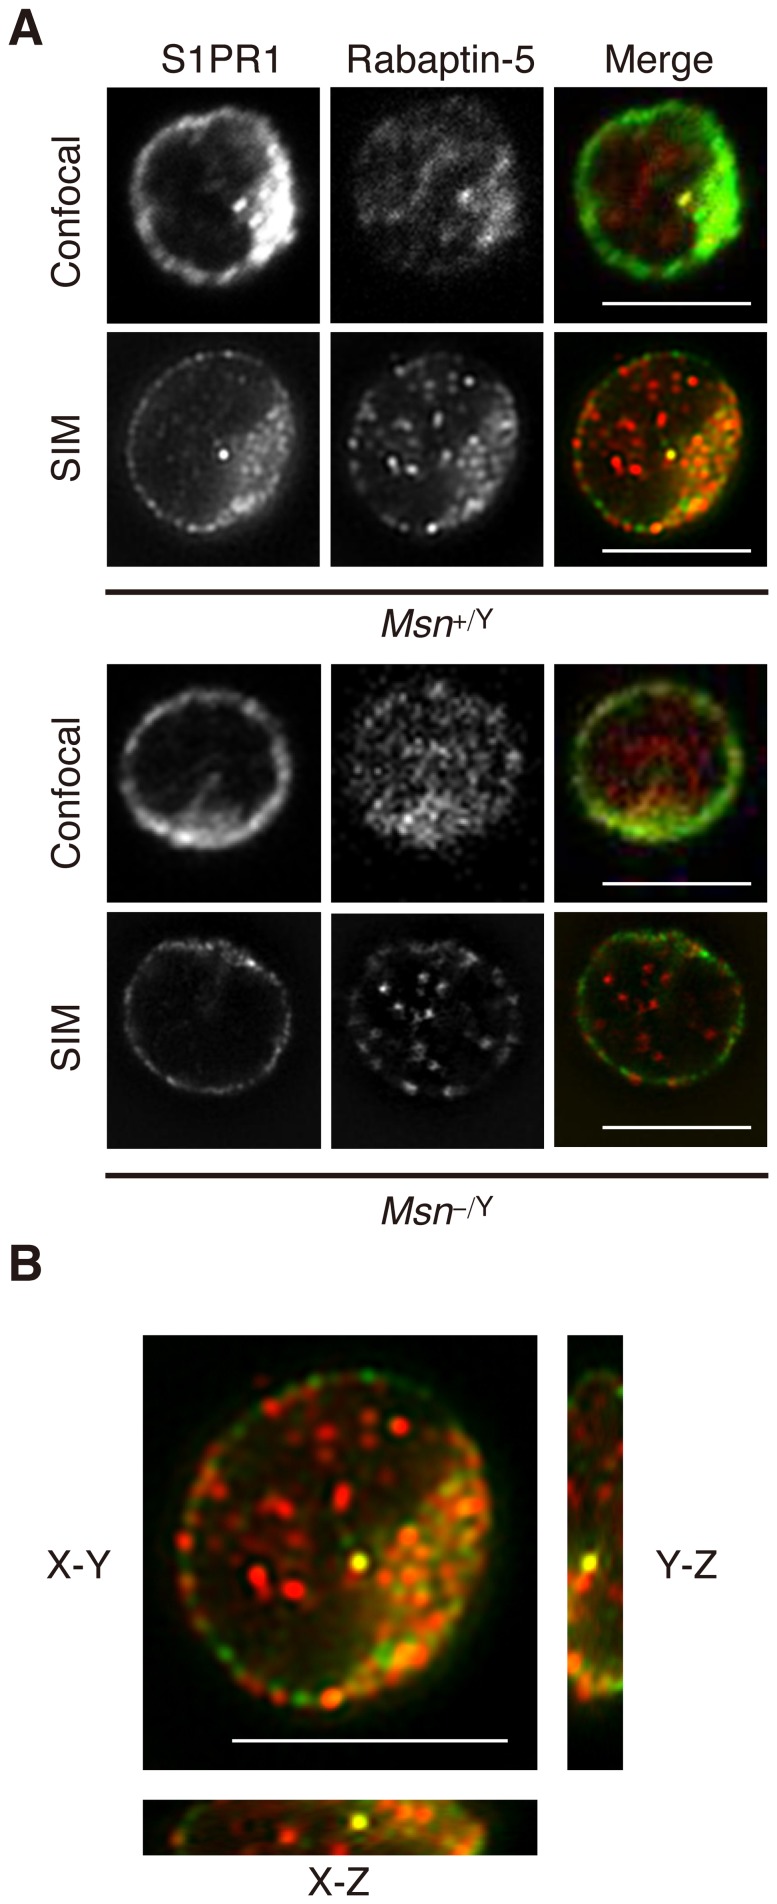
Super-resolution SIM images of S1PR1 and Rabaptin-5 localization in S1P-stimualted CD4+ T cells.(A) Representative SIM images of S1PR1 and Rabaptin-5 localization in S1P-stimualted CD4+ T cells and corresponding confocal images. Lymph node CD4+ T cells from Msn
+/Y and Msn
−/Y mice were incubated with 100 nM S1P for 1 h, fixed, permeabilized, and stained with anti-S1PR1 and anti-Rabaptin-5. Scale bars, 5 µm. (B) SIM image with orthogonal side views (XZ, YZ) depicting colocalization of S1PR1 and Rabaptin-5 in S1P-stimulated CD4+ T cells from Msn
+/Y mice. Scale bar, 5 µm.